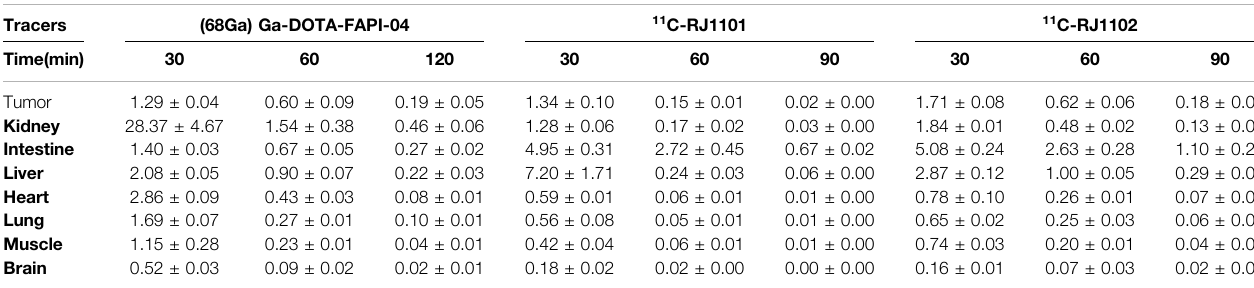
TABLE 1 | The distribution of three molecular probes in different organs. Tracers